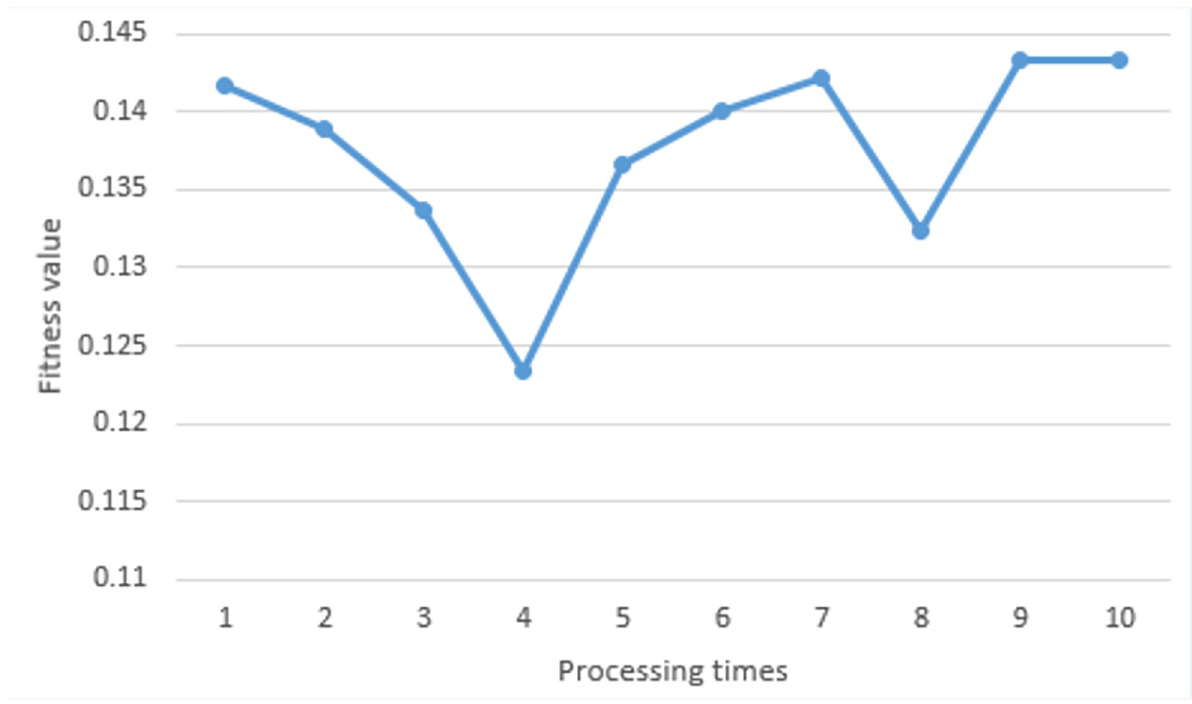
Fig 20. The fitness value obtained in a static environment (5